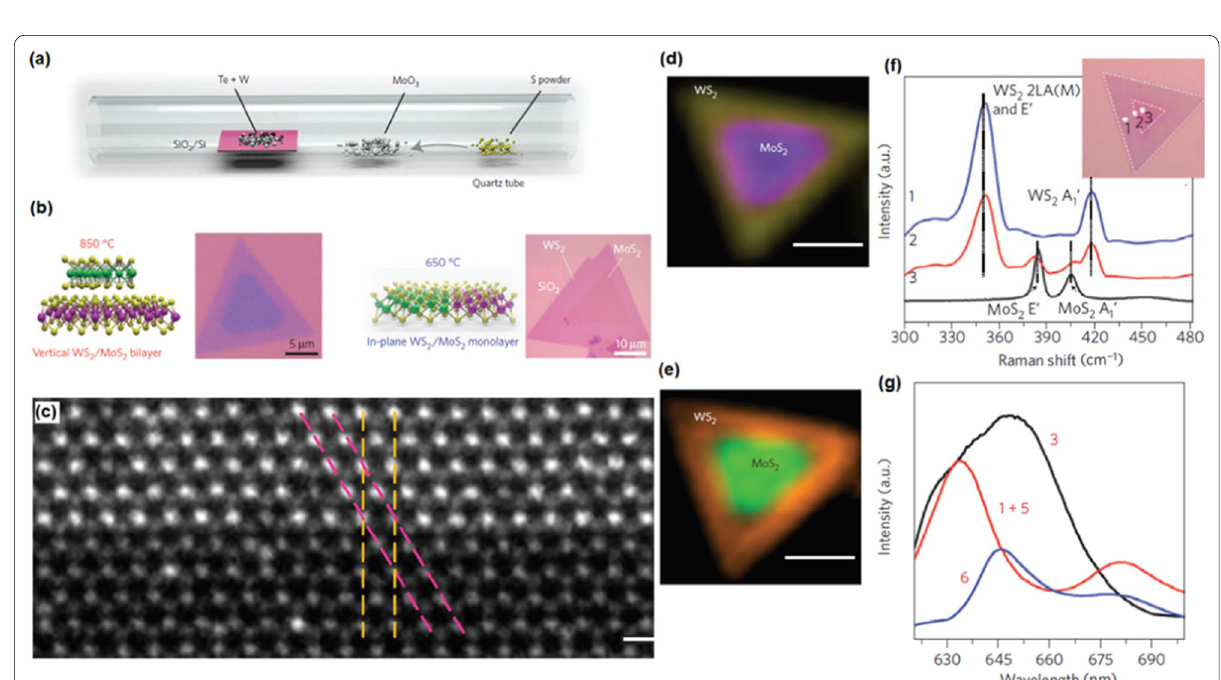
Fig. 5 a Schematic of CVD growth of semiconductor/semiconductor lateral 2D heterostructures. b Atomic resolution contrast STEM images of in-plane interface between WS 2 and MoS 2 . c The Raman intensity mapping of 2D heterostructured 2D film at 351 cm − 1 (yellow) and 381 cm − 1 (purple). d The combined PL intensity mapping at 630 nm (orange) and 680 nm (green). Reprinted and reproduced with permission from